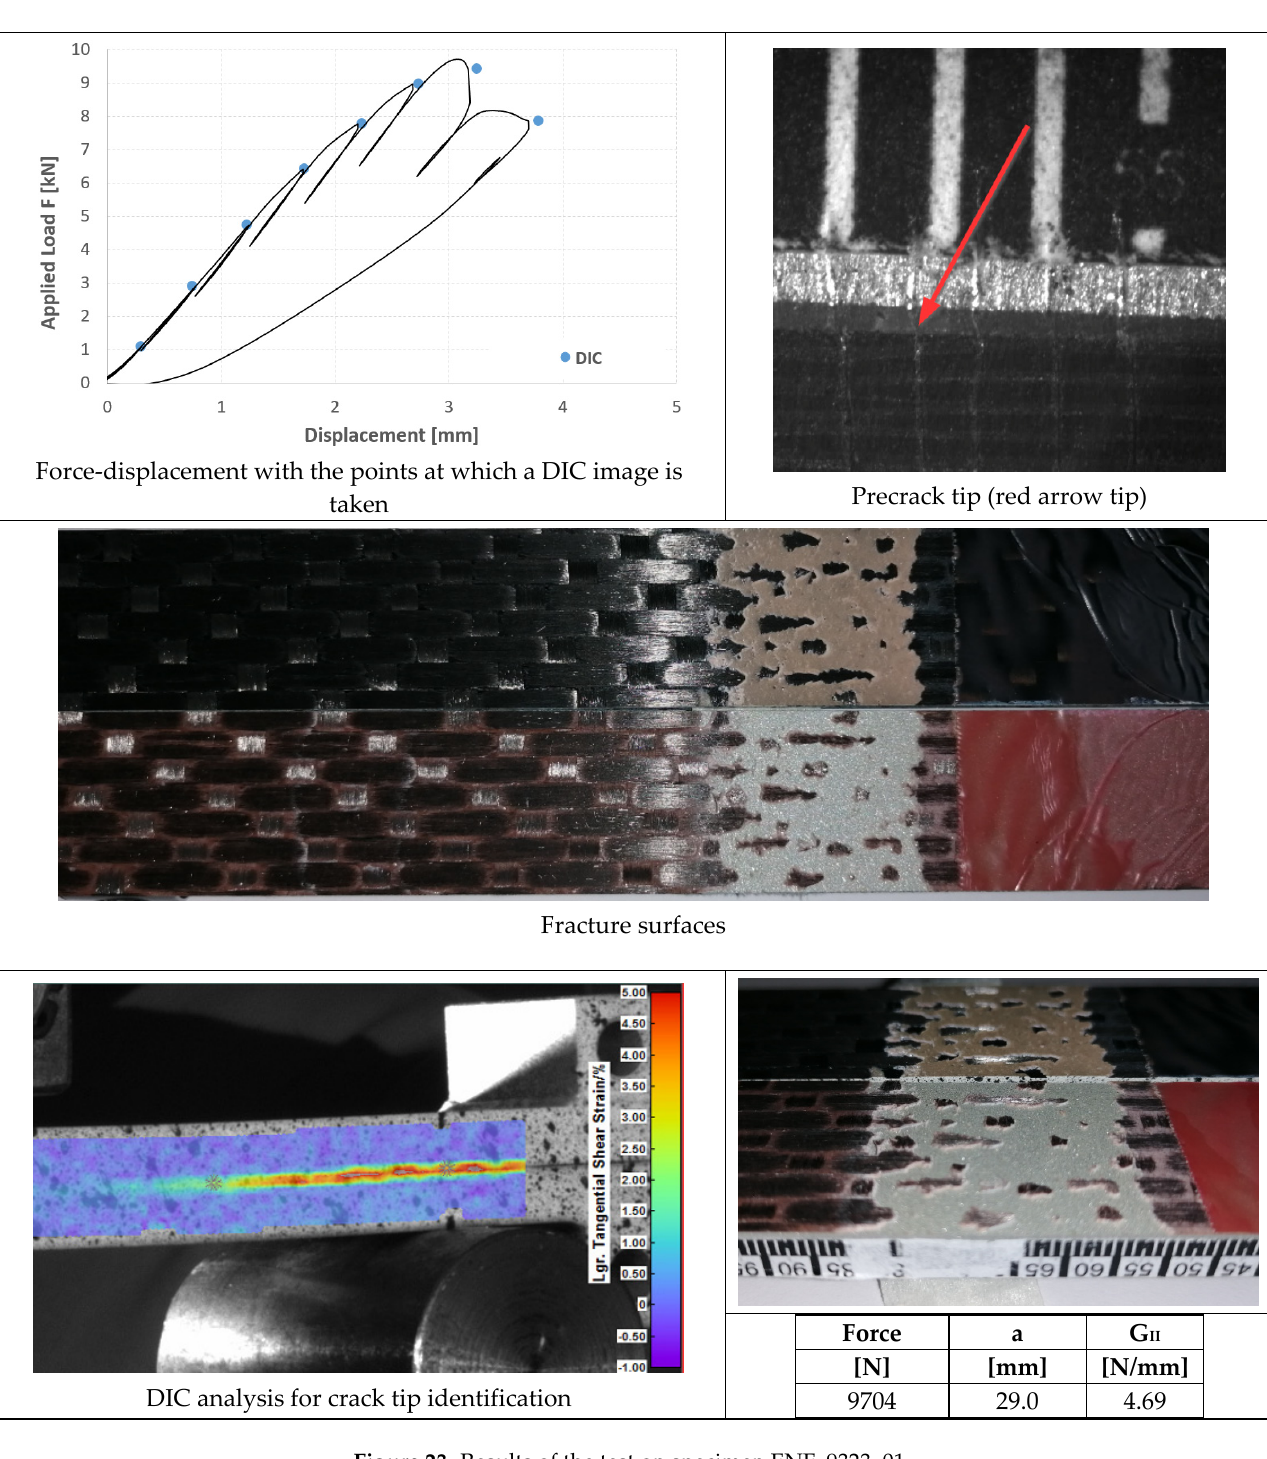
Figure 23. Results of the test on specimen ENF_9323_01.